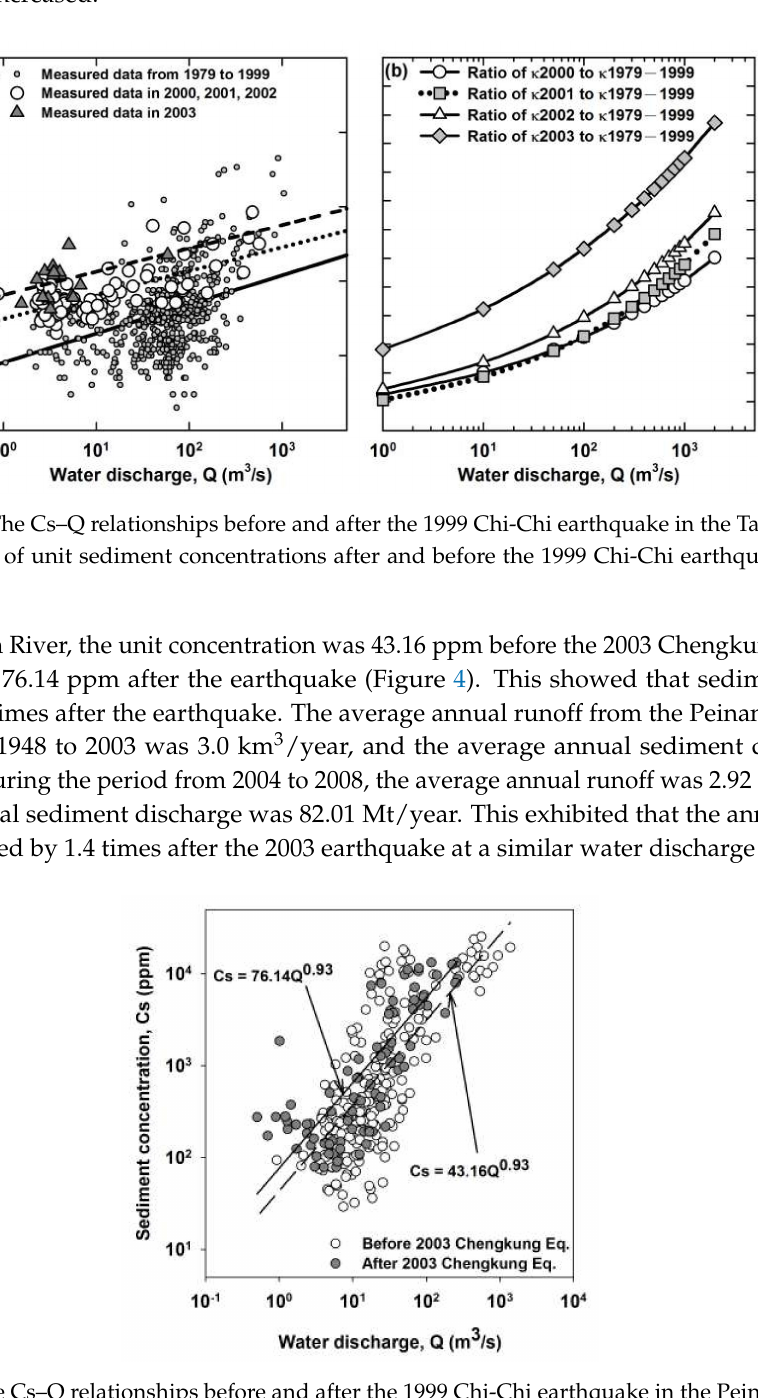
Figure 4. The Cs–Q relationships before and after the 1999 Chi-Chi earthquake in the Peinan